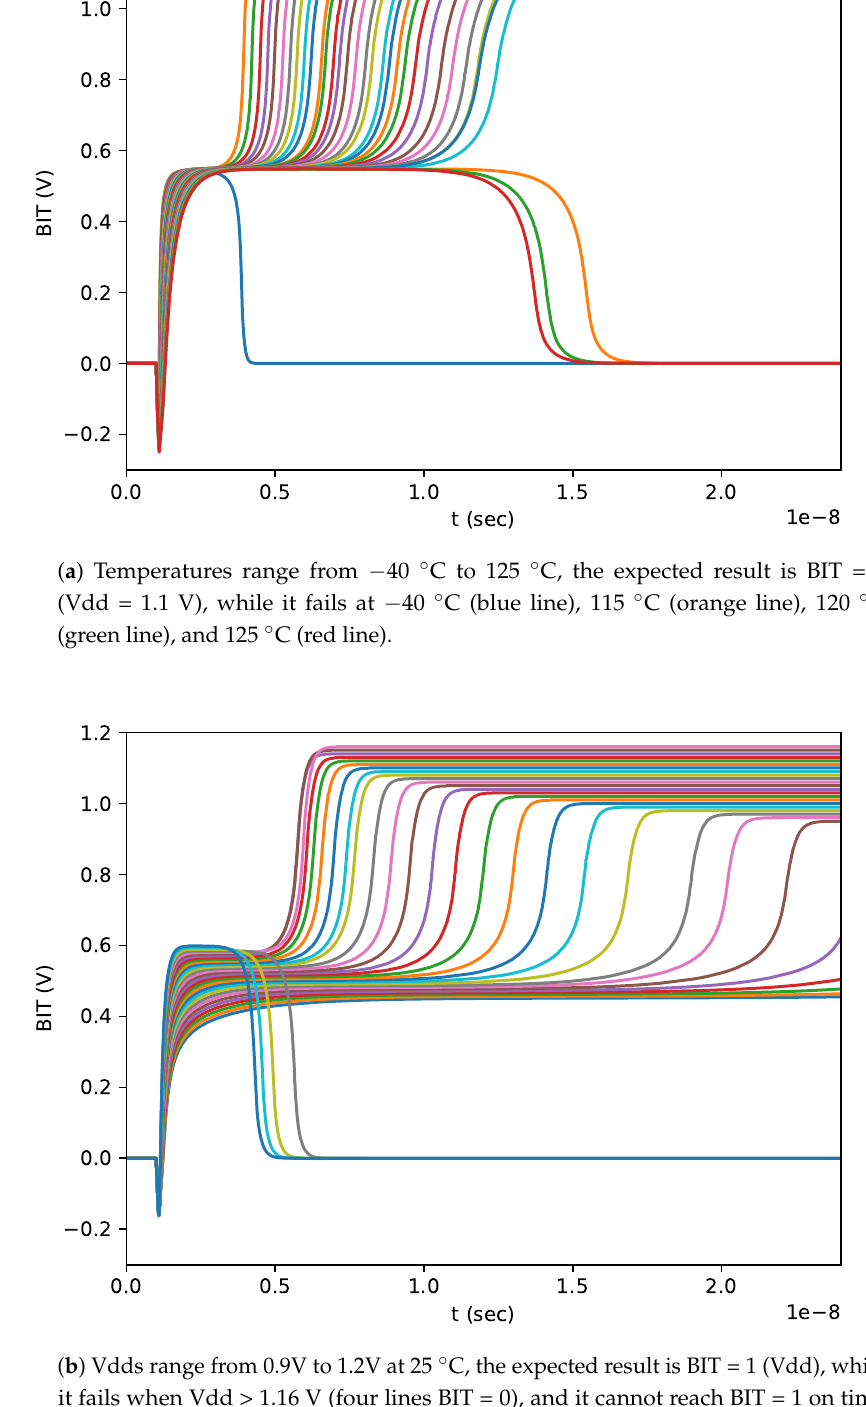
Figure 12. Reliability validation of P S under two MTJs with a bit resistance-area product (RA) difference, MTJ A: 5 Ω - µ m 2 and MTJ B: 5.2 Ω - µ m 2